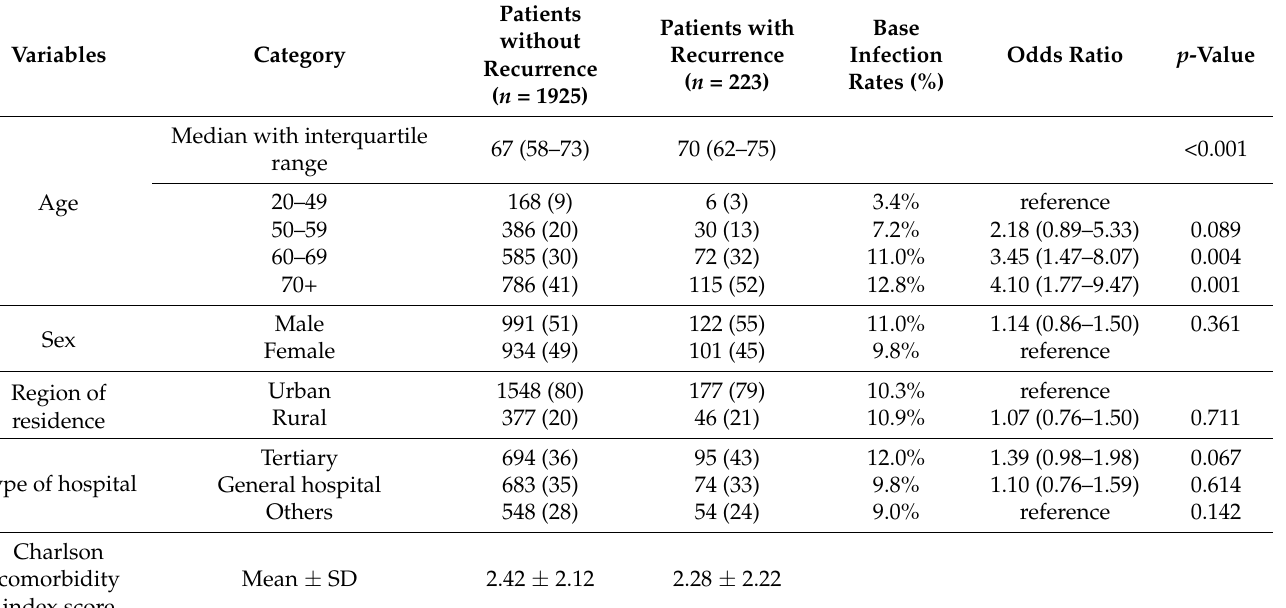
Table 2. Comparison of baseline patient